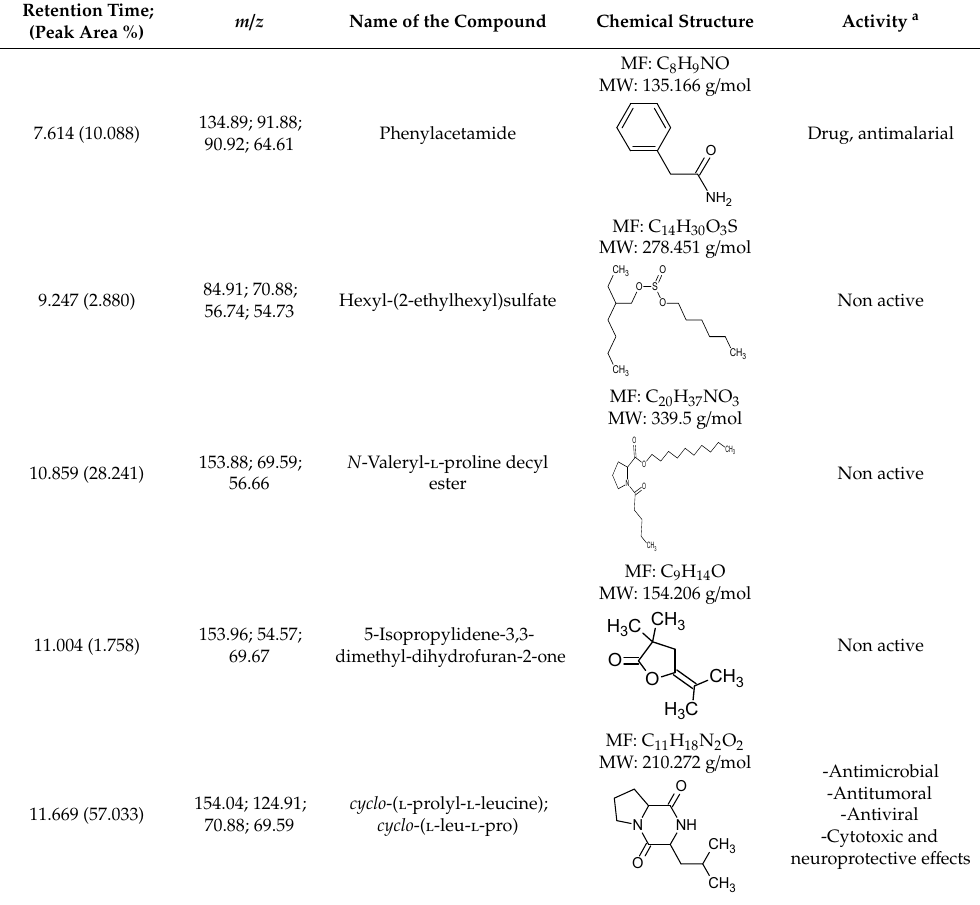
Table 1. Compounds obtained from the active biological fraction produced by Streptomyces misionensis strain V16R3Y1 by GC-MS